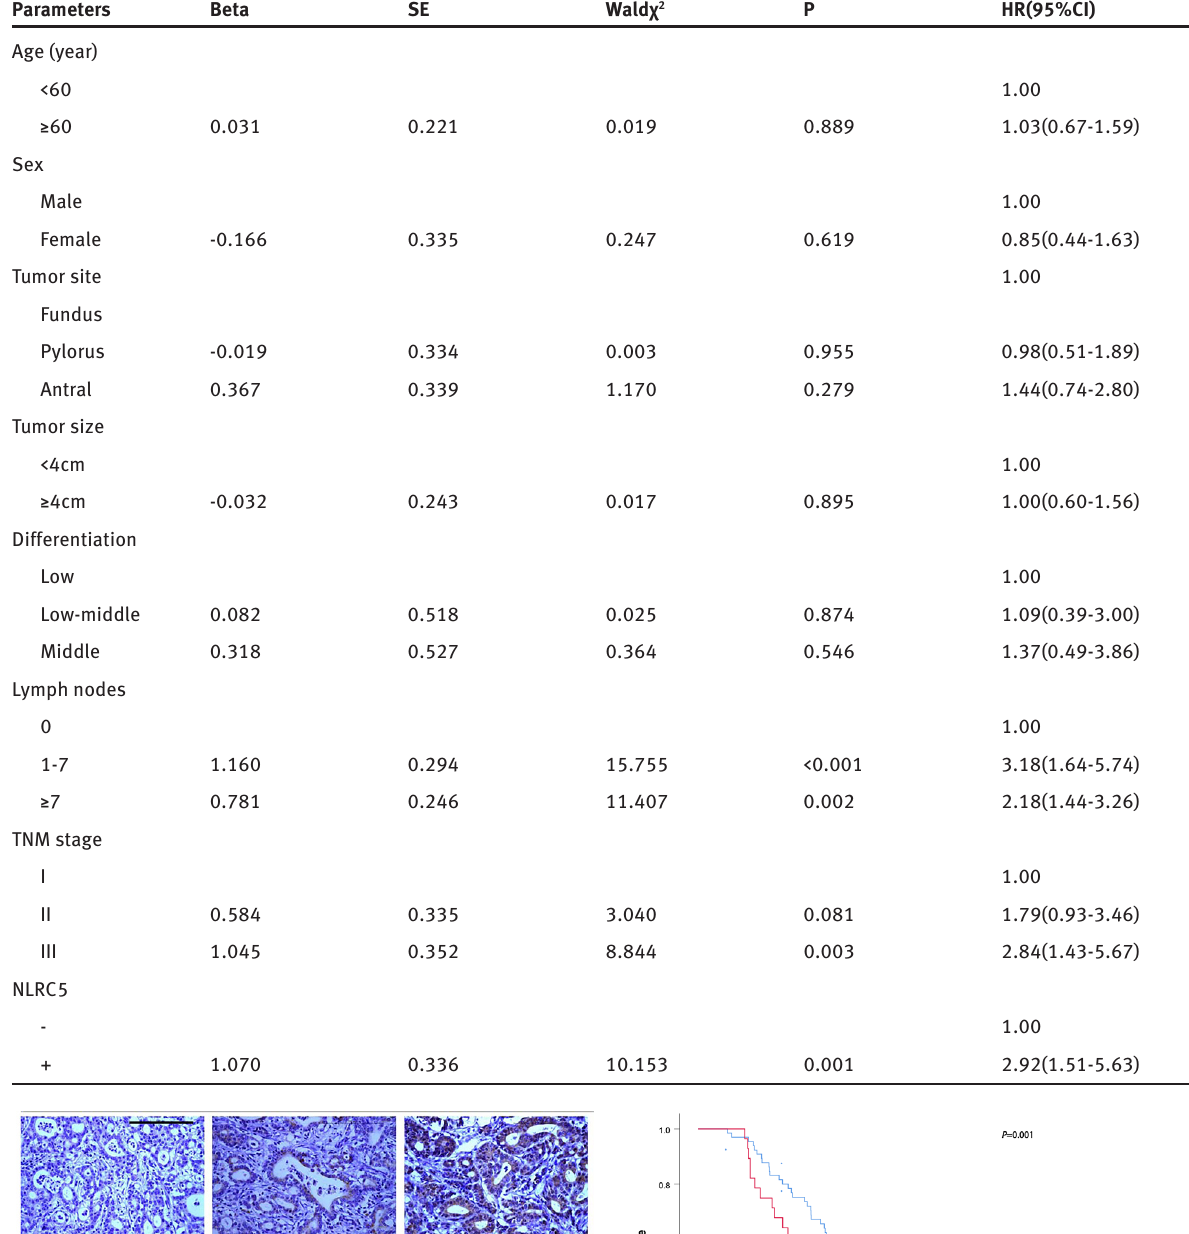
Table 2: Univariate Cox regression analysis of relationship between clinicopathological characteristics and prognosis in patients with gastric cancer